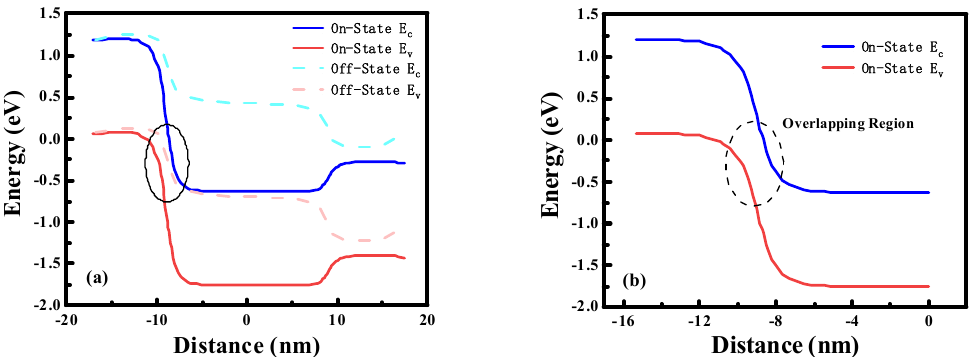
Figure 7. ( a ) Schematic of band diagrams of Fe-ED NSTFETs. ( b ) Energy band diagram at the junction of the source and the channel region.